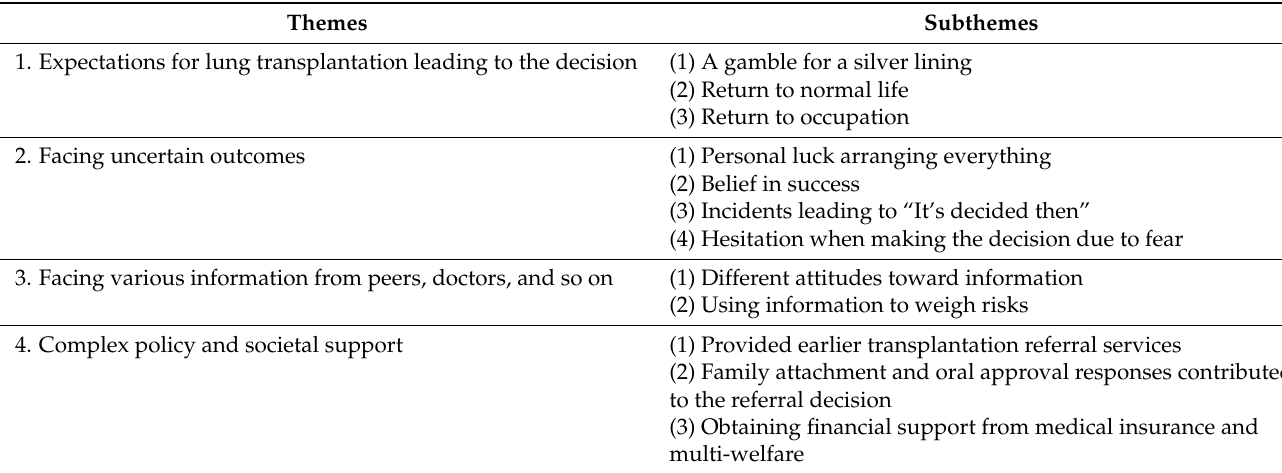
Table 3. Themes and